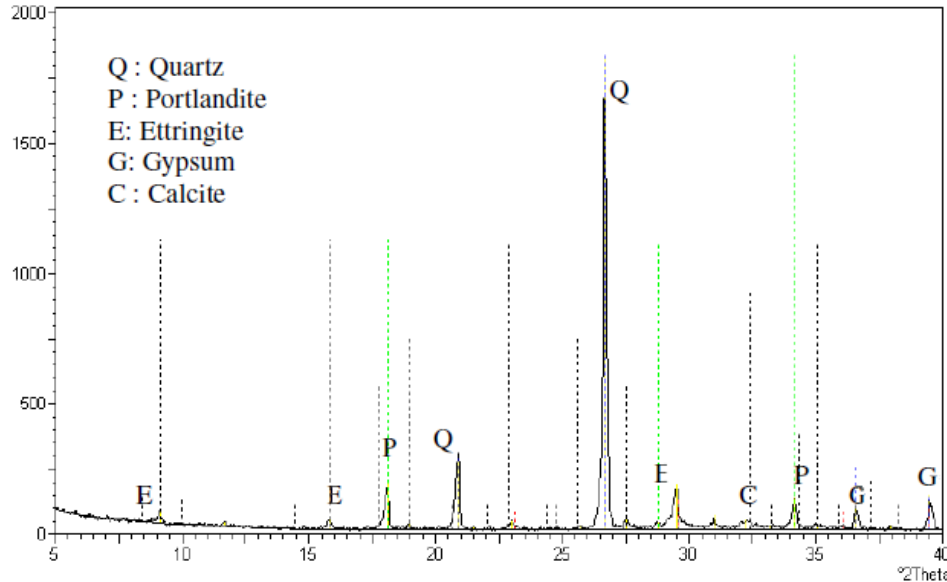
Figure 13. XRD of dune sand mortars immersed in sodium sulfate solution (5%) at 180 days [73].